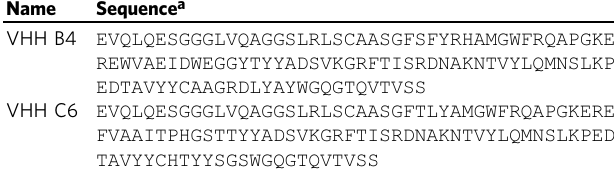
Table 2 Amino-acid sequences of the PLN-speci fi c VHHs, VHH B4 and VHH